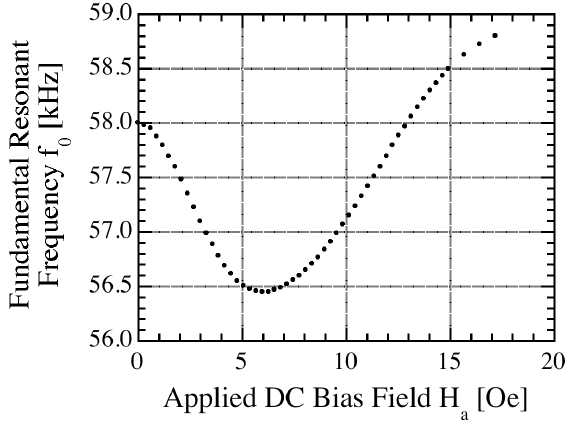
Figure 3. Resonant frequency of a 2826MB magnetoelastic sensor ribbon as a function of applied magnetic DC biasing field. Reprinted with permission from [18].